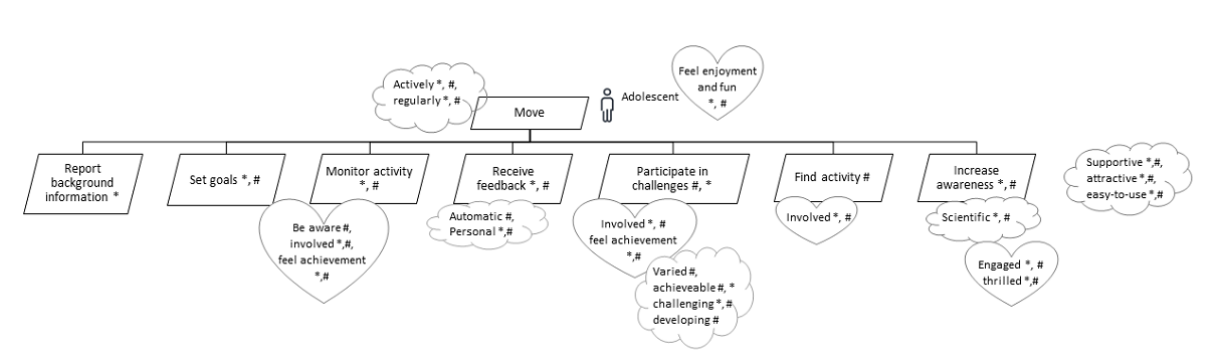
Figure 2. Overall goal model for information and communication technology solutions supporting physical activity levels of adolescents. The “*” in the model represents findings from the literature; the “#” represents suggestions by